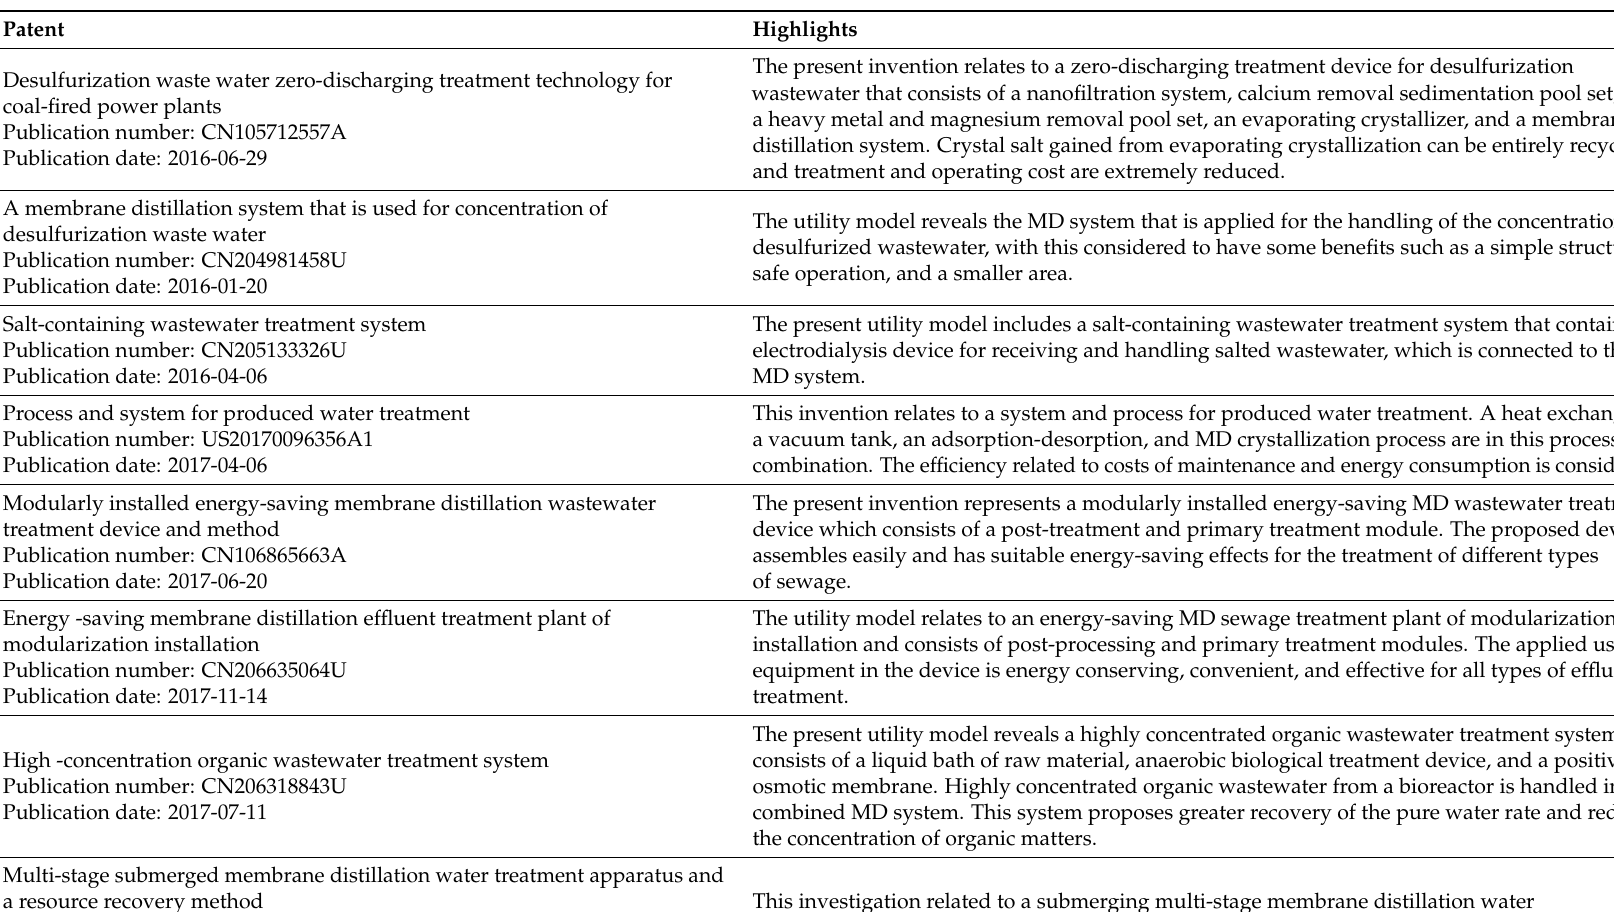
Table 1. List of published patents in the application of membrane distillation (MD) in wastewater treatment (2016 to 2018).